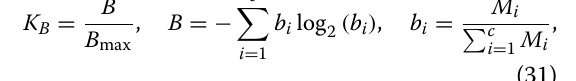
(3) Link diversity K B The link diversity K B is defined to quantify the geomet- ric constraints between neighboring joints. For a revo- lute joint, its axis of rotation is considered, whereas, for a prismatic joint, its direction is considered. Five possi- ble joint constraint types between the neighboring joint axes/directions were reported previously [39].